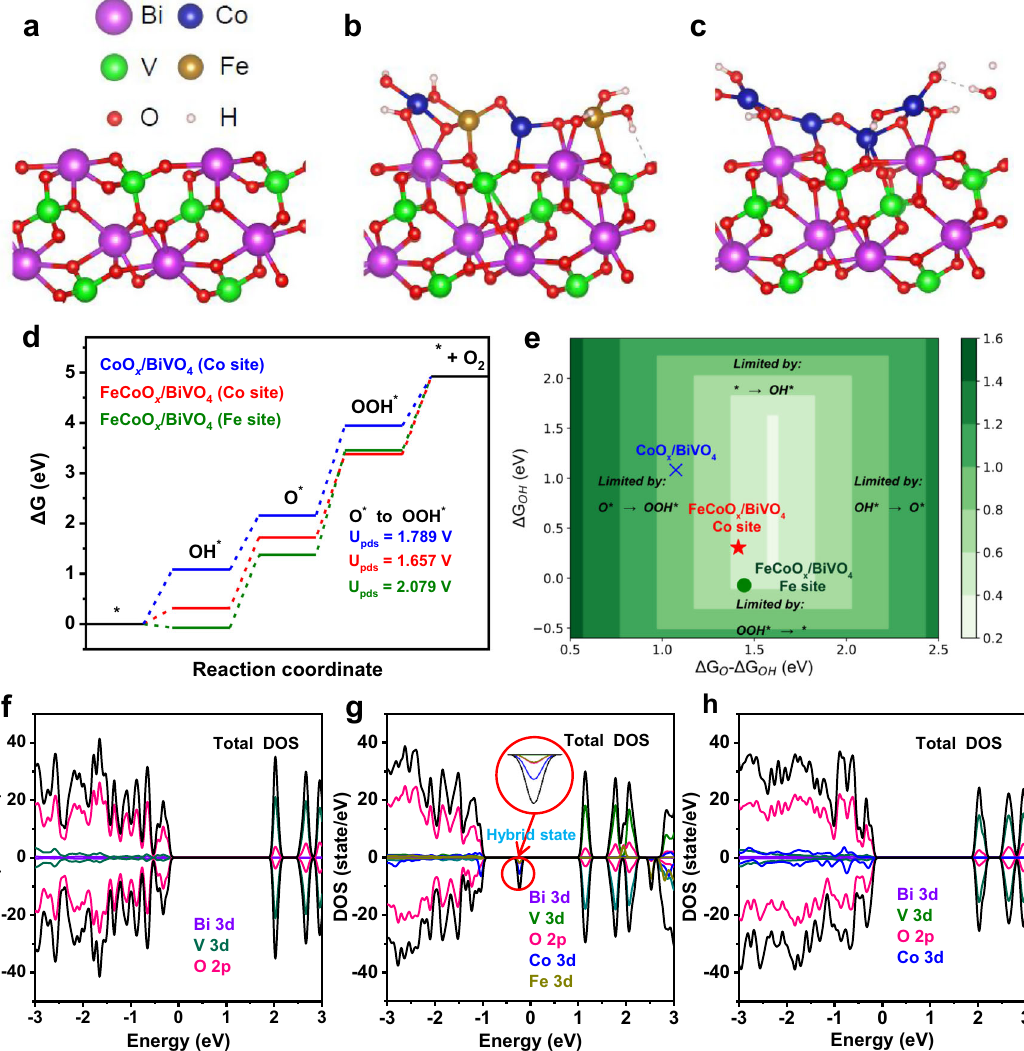
Fig. 4 Theoretical understanding of the promotion effect of the FeCoO x cocatalyst. Visual representation of structures of BiVO 4 {110} surface ( a ) FeCoO x /BiVO 4 {110} interface ( b ) and CoO x /BiVO 4 {110} interface ( c ) for the DFT calculations. d Free energy diagram for OER process on FeCoO x /BiVO 4 and CoO x /BiVO 4 {110} interfaces. The surface structures with various reaction intermediates are shown alongside the free energy diagram. U pds , equilibrium potential for the potential determining step. e Theoretical overpotential plot with O ∗ and OH ∗ binding energies as descriptors. Calculated densities of state for the BiVO 4 {110} surface ( f ), FeCoO x /BiVO 4 {110} interface ( g ), and CoO x /BiVO 4 {110} interface ( h